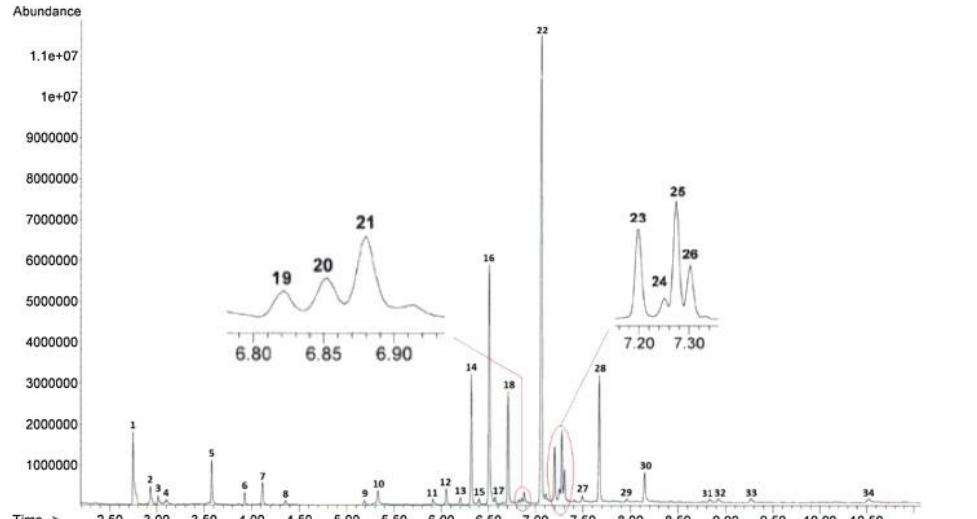
Figure 3. Typical chromatograms of the actual street nyaope samples analyzed through GC-MS. (1) nicotine; (2) α - caryophyllene; (3) α -humelene; (4) α/β -selinene; (5) phenacetin; (6) neophyltadiene;